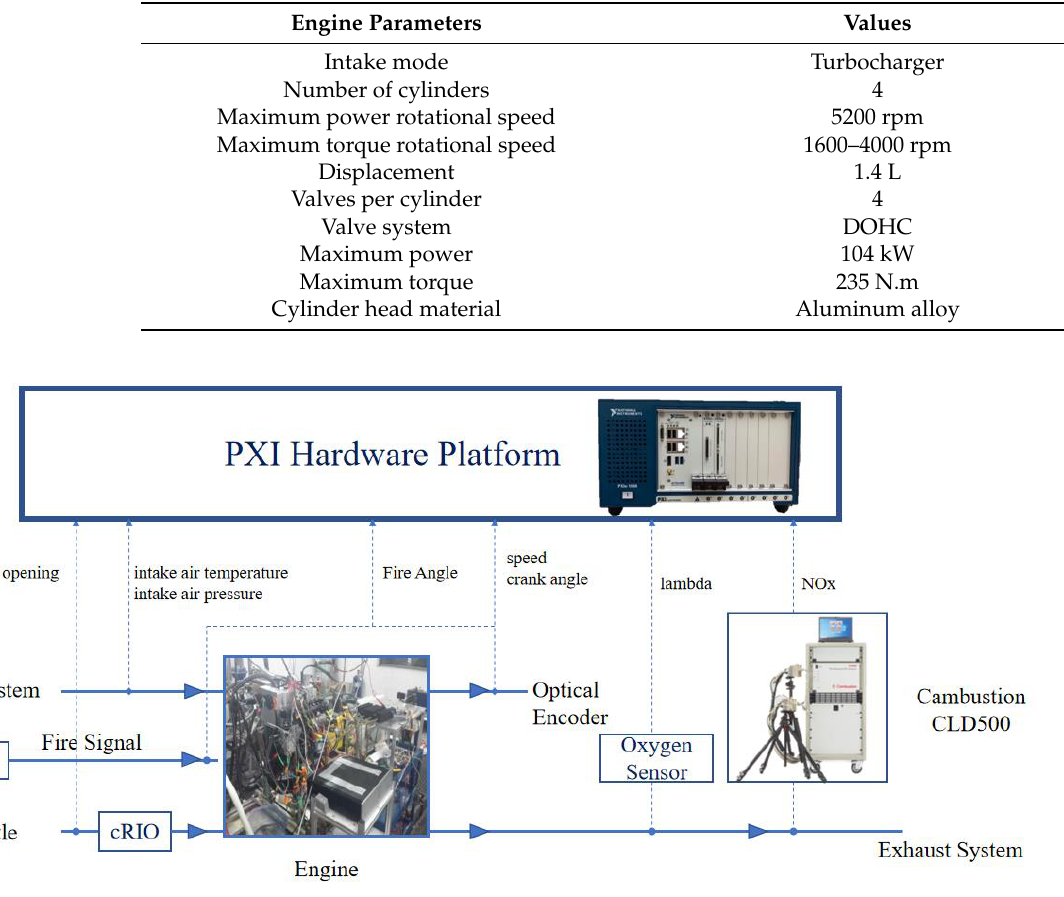
Figure 5. Schematic diagram of the test bench. The bench is composed of the engine, the dynamometer, data acquisition system PXI, CLD500 fast analyzer and other sensors.